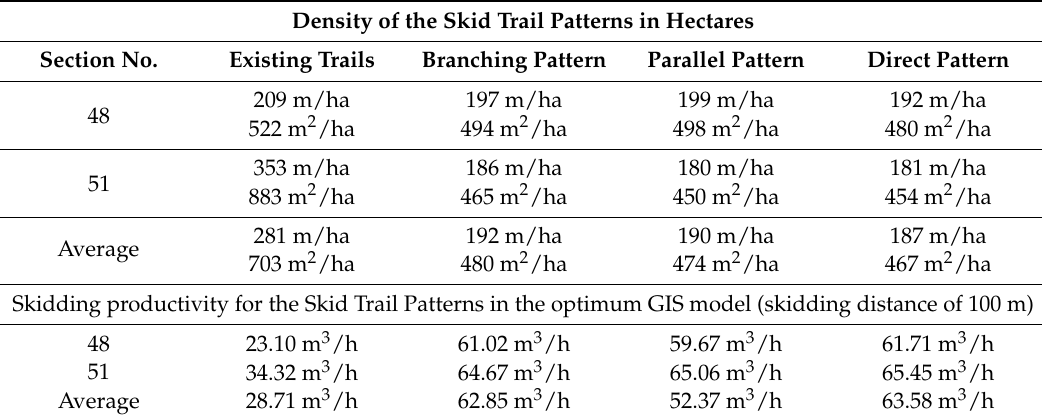
Table 2. Road density and skidding productivity on the skid trail patterns. Density of the Skid Trail Patterns in